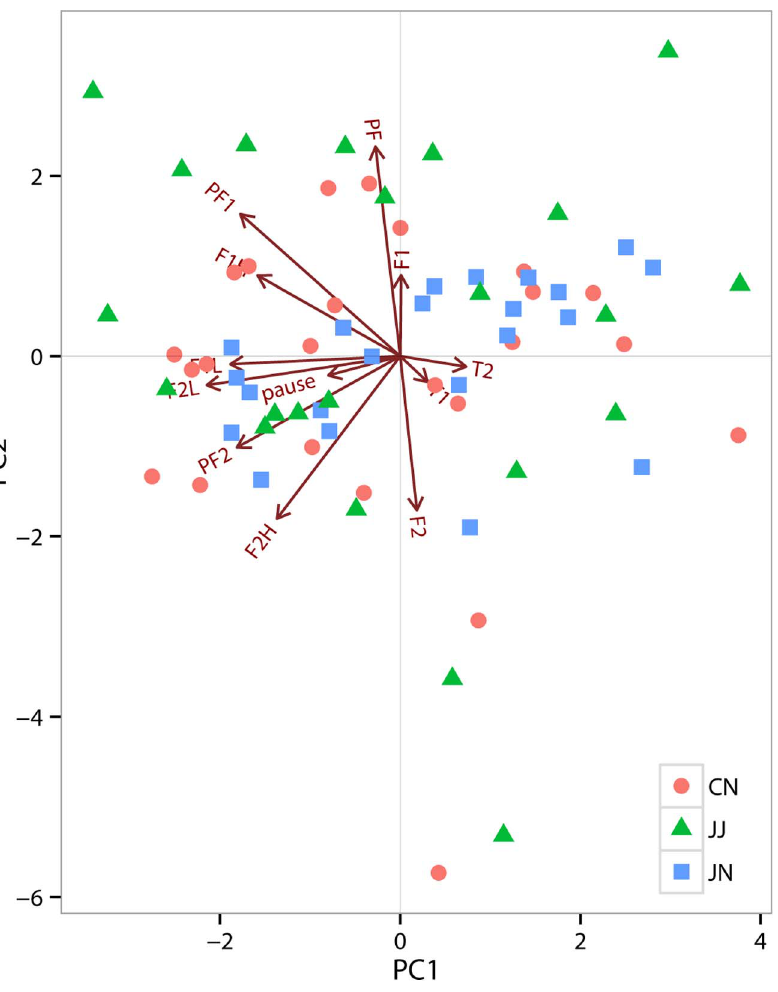
Figure 4. Scatter plot of the principal component analysis for male cuckoo calls in three populations. The first two principal components were plotted and each symbol represents a different population.